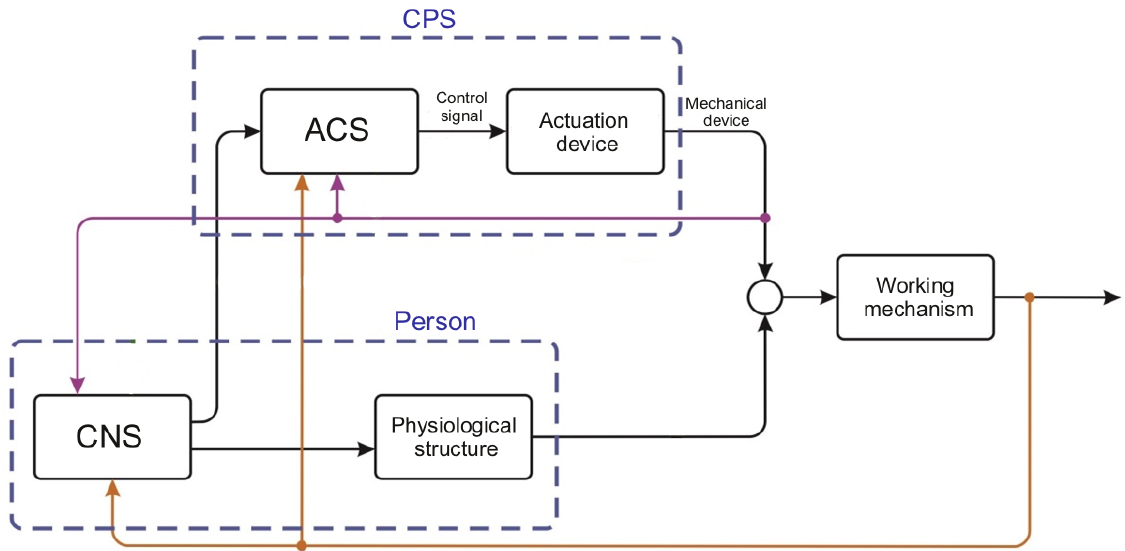
Figure 1. Block scheme of a biocybernetic system.